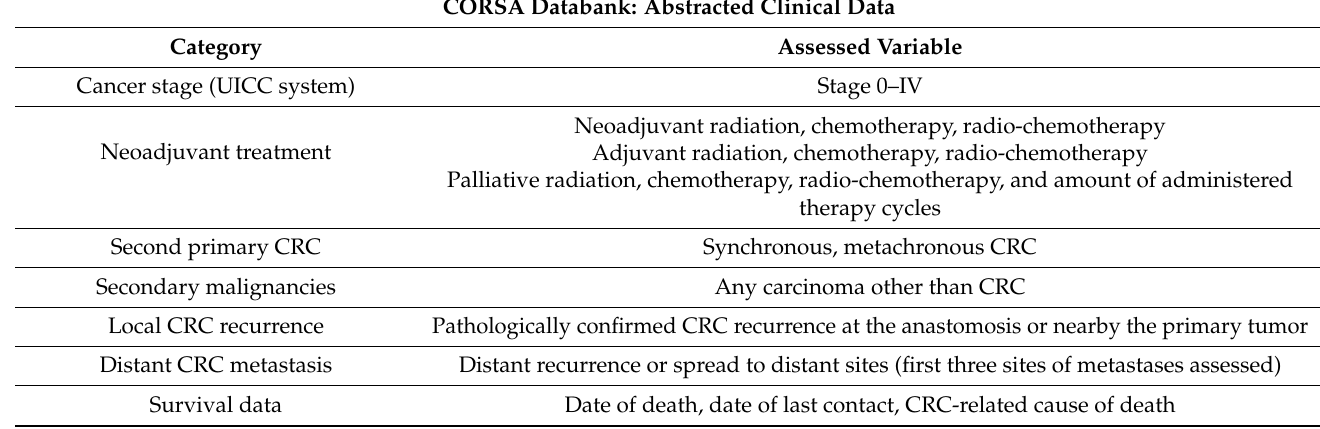
Table 2. Cont . CORSA Databank: Abstracted Clinical